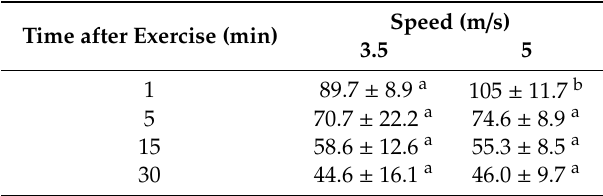
Table 3. Recovery heart rate at di ff erent times after 60 min of exercise at di ff erent speeds (mean ± SD; 7 horses).